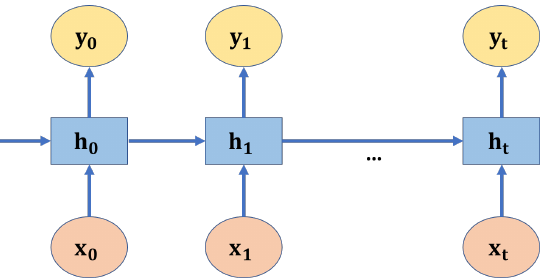
Figure 2. A recurrent neural network architecture.